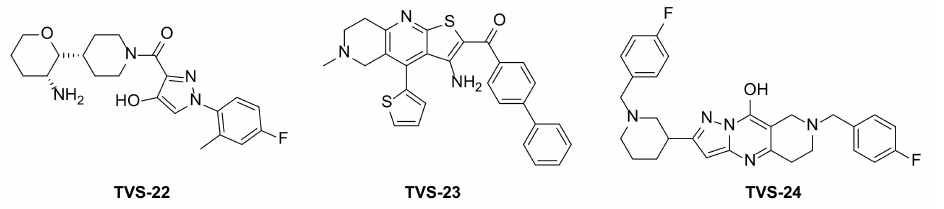
Figure 2. Virtual screening hits tested for antiproliferative activity in cancer cell